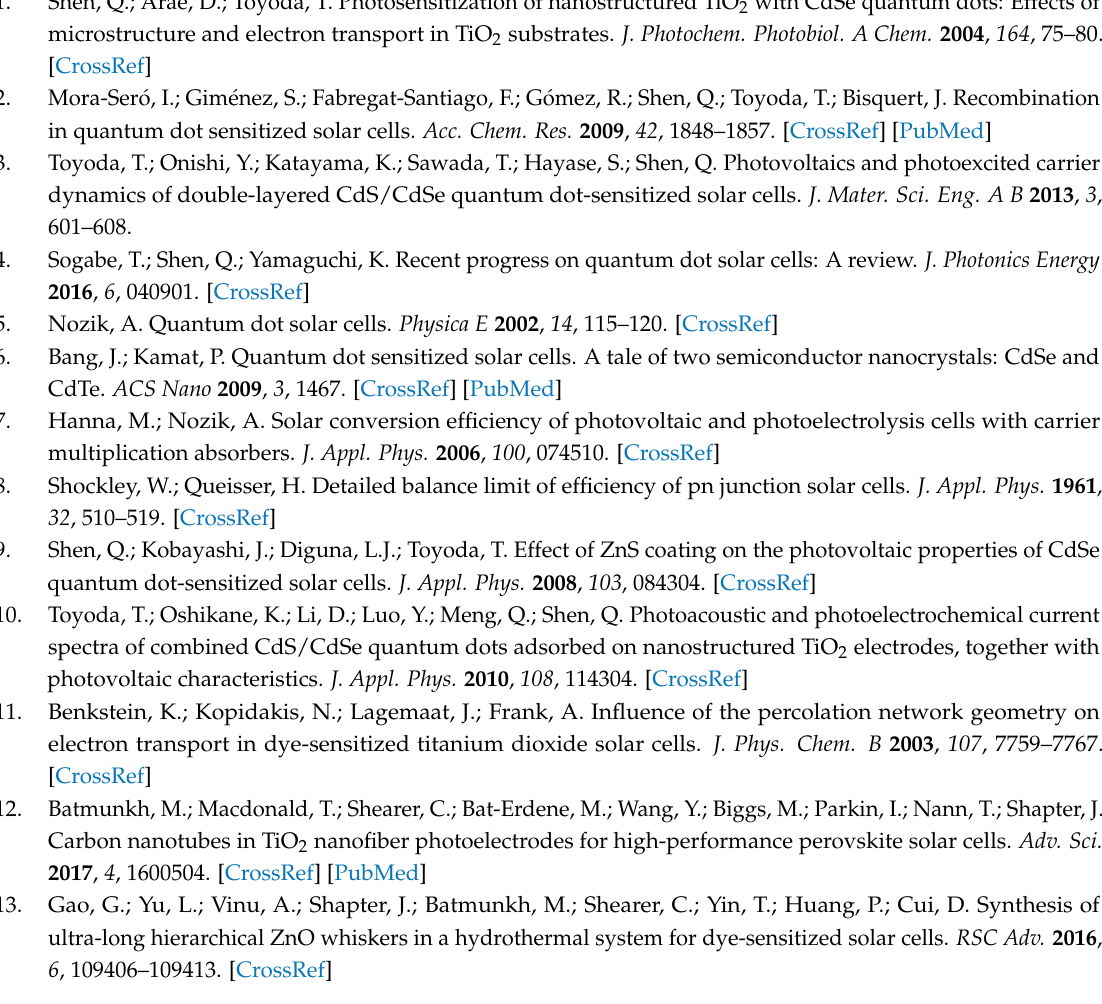
Figure S1: PA spectra of CdSe sensitized IO-TiO 2 with and without ZnS passivation, Figure S2: TEM images of IO-TiO 2 , IO-TiO 2 /ZnS and IO-TiO 2 /ZnS/CdSe QD/ZnS, Figure S3: TA responses for the CdSe QD deposited IO-TiO 2 with and without ZnS passivation, Figure S4: OCVD curves of IO-TiO 2 /CdSe QDSSCs, Figure S5: Impedance spectra of CdSe QDSSCs with and without ZnS passivation, Figure S6: Cross sectional SEM images of CdSe QD deposited IO-TiO 2 with and without ZnS passivation, Table S1: Fitting result of Figure